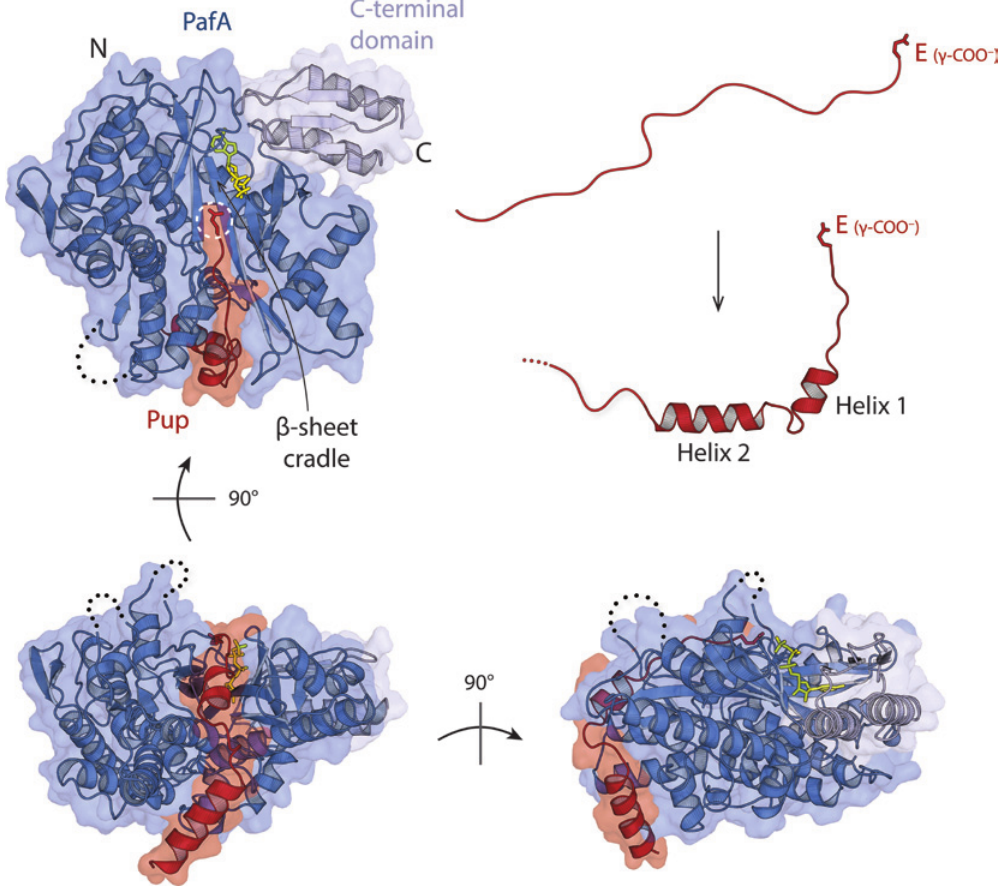
Figure 3: Crystal structure of the complex between Pup and the ligase PafA. PafA is composed of a larger N-terminal domain of about 400 residues (dark blue) and a smaller C-terminal domain of about 70 residues (light blue). The active site comprises a concave β -sheet with ATP (yellow) bound at one end of the sheet and the C-terminal residue of Pup (red) bound at the opposite end. The γ -carboxylate of Pup’s C-terminal glutamate (highlighted by a dashed white circle) is positioned for phosphoryl transfer from ATP. The C-terminal half of Pup binds into a long, conserved groove, leading away from the β -sheet cradle and wrapping Pup around to the opposite side of the PafA monomer. Upon binding, the intrinsically disordered Pup folds into two orthogonal helices connected by a short